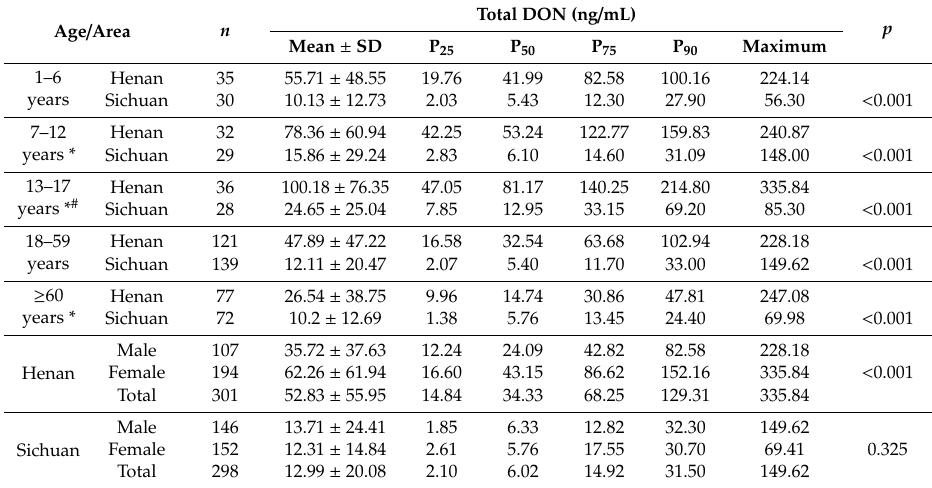
Table 1. Urinary total deoxynivalenol (tDON) concentrations of the